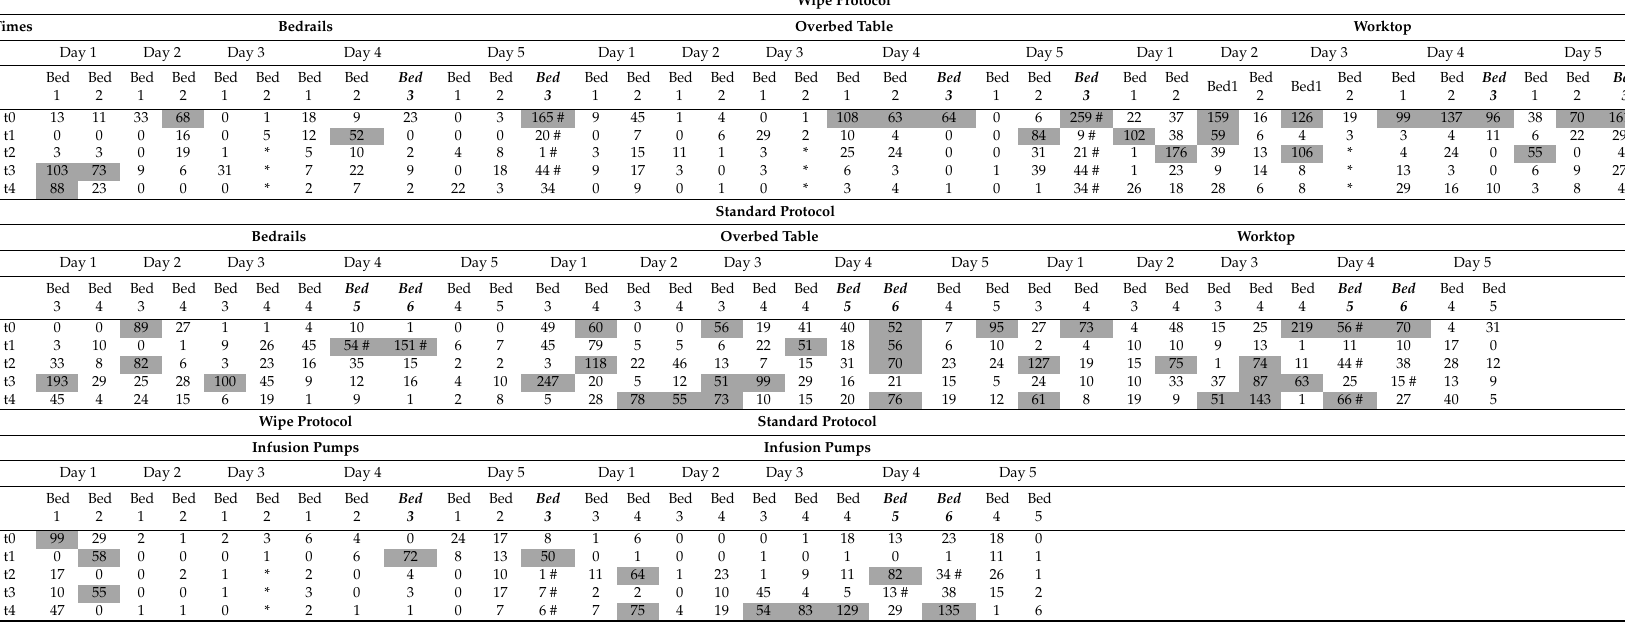
Table 1. Hygiene failures before and after the cleaning and disinfection procedures on non-electromedical surfaces and on the infusion pumps. Note: t0 = before cleaning and disinfection, t1 = 30 min after, t2 = 2.5 h after, t3 = 4.5 h after, t4 = 6.5 h after. Grey boxes indicate the hygiene failures (>50 CFU/24 cm 2 ); Bed in bold italics indicates a bed occupied by a CRAB positive patient; the hash symbol (#) indicates environmental site positive for CRAB and the asterisk symbol (*) indicates patient transferred to another